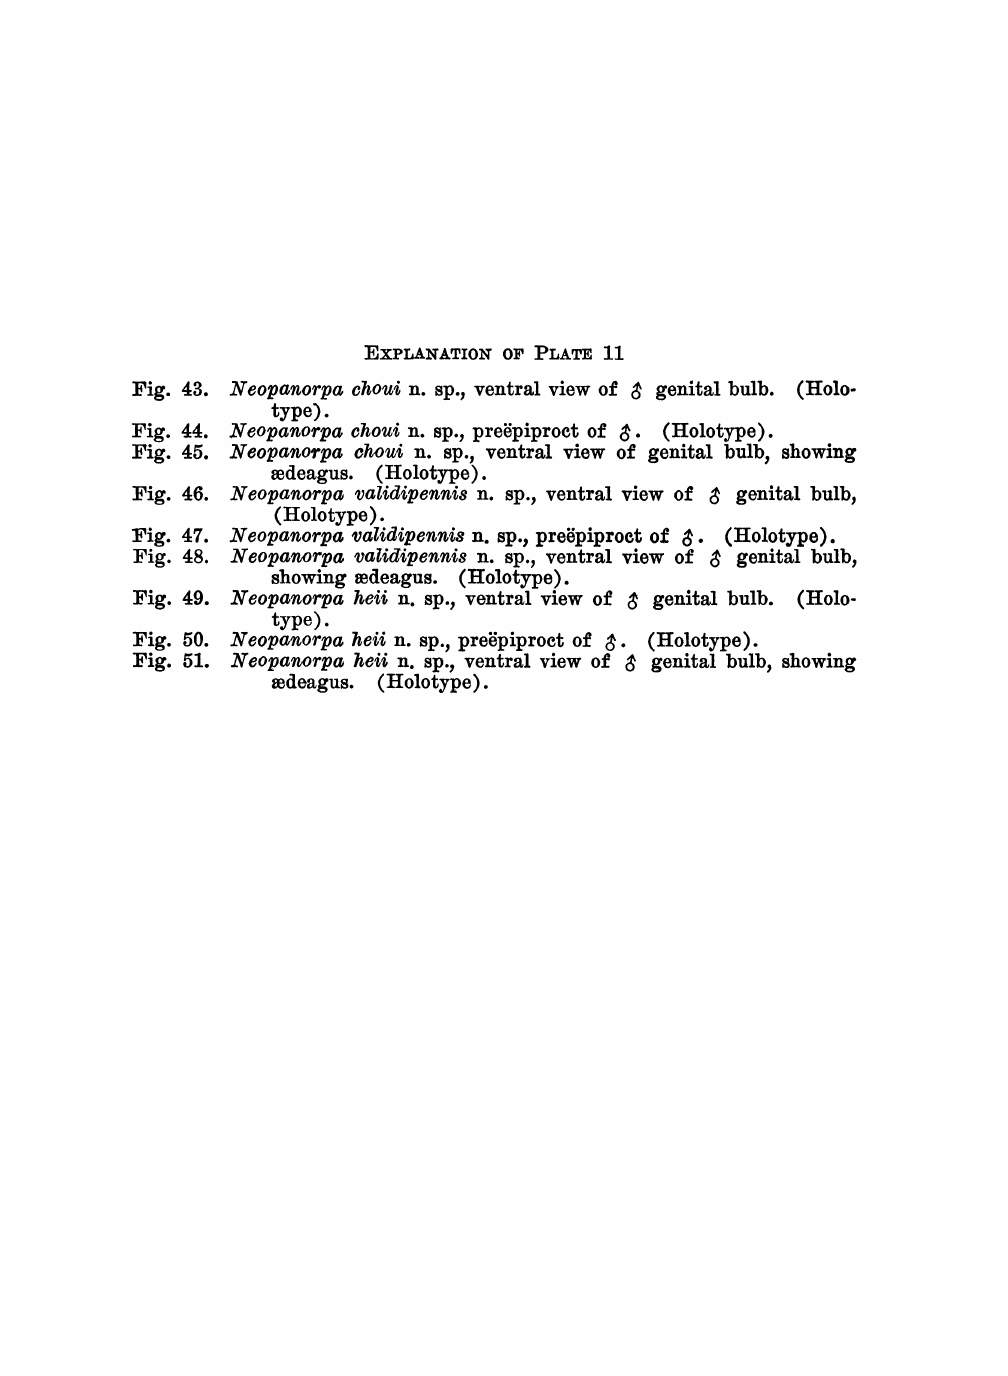
EXPLANATION 01 PLATE II Neopanorpa vhou n. sp., ventral view of $ genital bulb. (Holo- Fig. 43. type). Neopanorpa vhoui n. sp., prepiproct of $. (Holotype). Fig. 44. . Neopanorpa vhoui n. sp., ventral view of genital bulb, showing Fig. 45. mdeagus. (Holotype). Neopanorpa validipennis n. sp., ventral view of $ genital bulb, lig. 46. (Holotype). Neopanorpa validpennis n. sp., prepiprot of (Holotype). Fig. 47. . Neopanorpa alidipennis n. sp., ventral view of $ genital bulb, Fig. 48. showing edeagus. (Holotype). eopanorpa hei n. sp, ventral view of $ genital bulb. (Holo- Fig. 49. type). Neopanorpa heii n. sp., prepiproet of (Holotype). ig. 50. Neopanorpa heii n. sp., ventral view of $ genital bulb, showing ig. 51. edeagus.